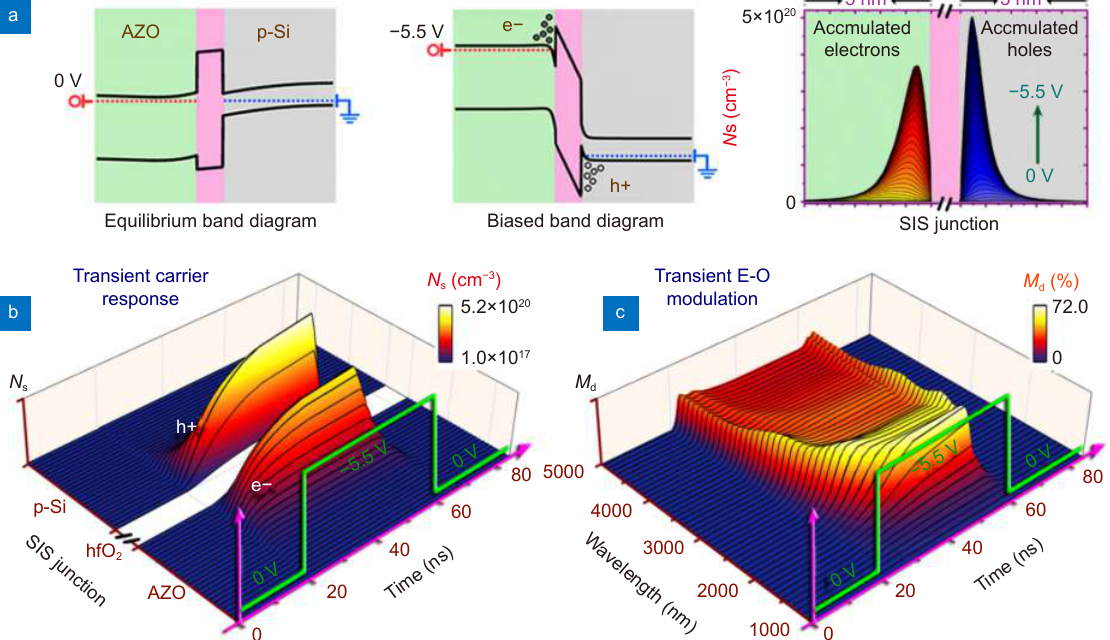
Fig. 5 | Transient E-O response of the AZO/HfO 2 /p-Si capacitor to applied switching voltage. ( a ) Quasistatic-state band diagram of the SIS junction with and without an external voltage bias (left and middle plots). The evolution of carrier distribution near the SIS junction for the capacit- or applied with gradually decreased voltages (right plot). ( b – c ) Transient carrier and E-O modulation of the proposed SIS capacitor. The E-O modulation property is calculated based on an optical model using the same geometry as that of Fig. 2 (i.e., AZO fully wrapped the nanotrench structure where the depth of the nanotrench is 1.5 μm. For the sake of reducing series resistance, the thickness of substrate is assumed to be 100